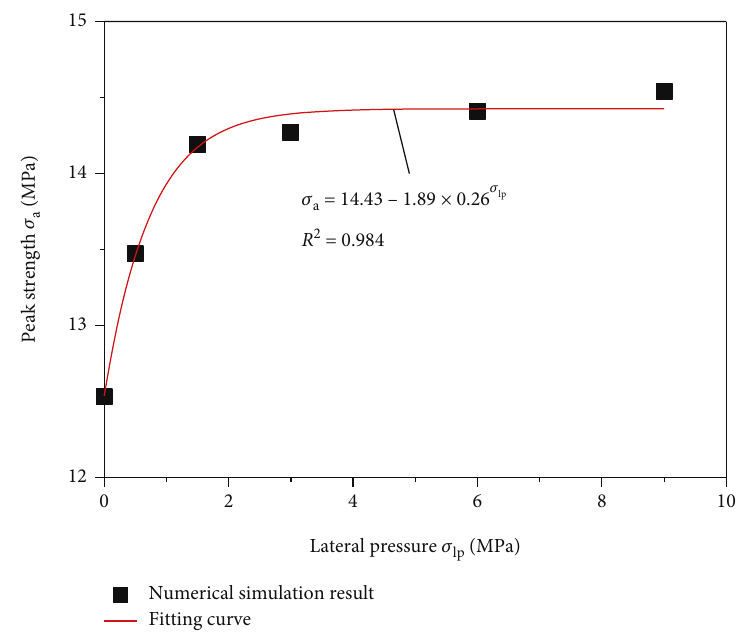
Figure 9: Relationship between peak strength and lateral pressure of rock mass specimen.